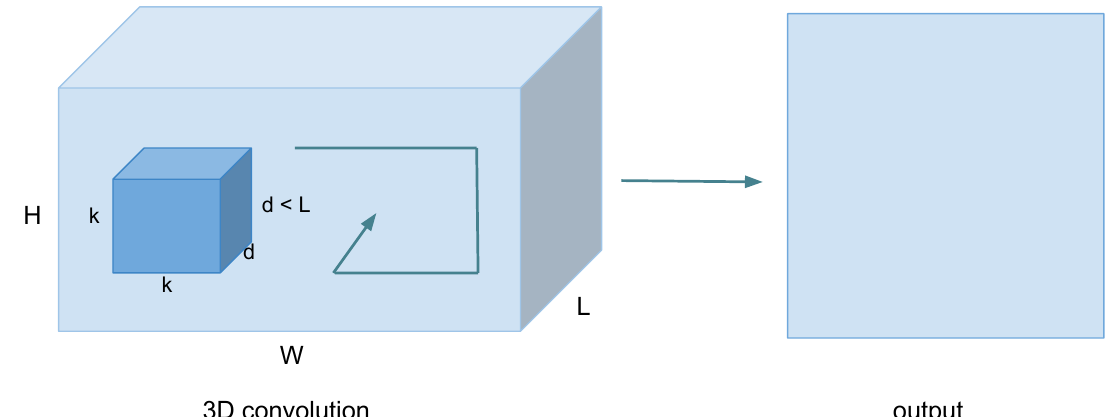
Figure 4. 3D convolution operations; the three directions ( x , y , z ) represent the calculation of a convolution. The output shape represents a 3D Volume; input = [ W , H , L ] and filter = [ k , k , d ] ; then, output = [ W , H , M ] , and most importantly, d < L for obtaining output